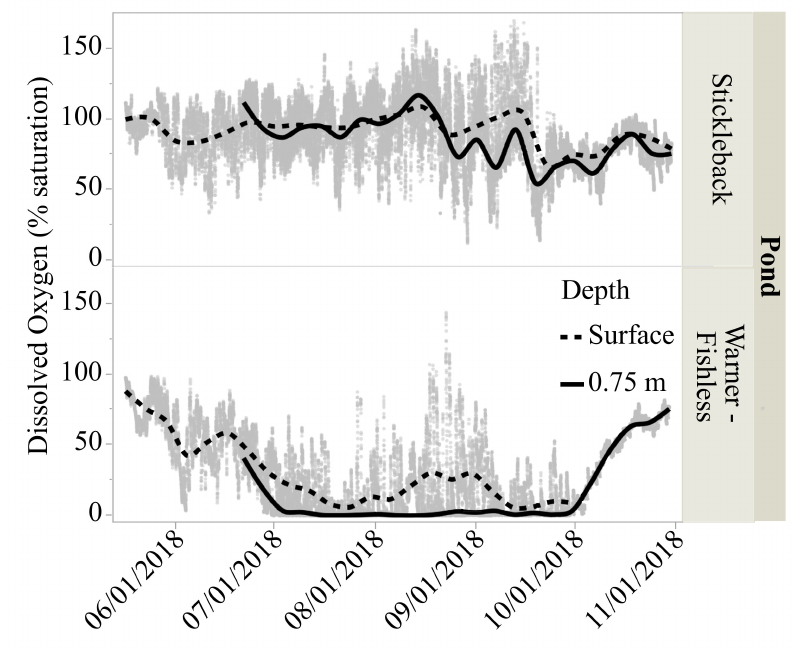
Figure 8. Percent dissolved oxygen at two di ff erent depths from two ponds in east-central Minnesota, USA. Fitted curves are cubic splines with a λ of